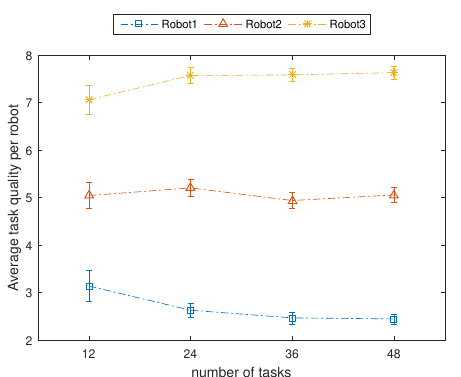
Figure 8. Quality satisfaction using a distributed multi-objective task allocation approach (DYMO-Auction).